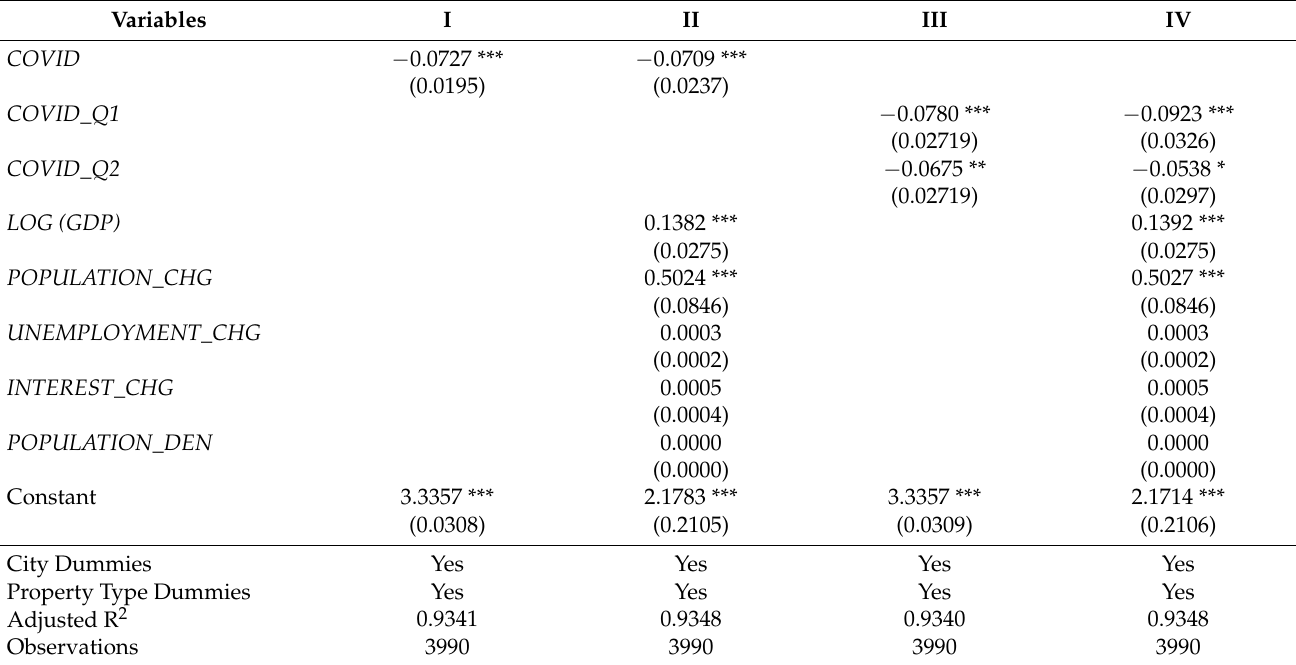
Table 3. The Impact of the COVID-19 Pandemic on Rent Dynamics. This table presents the OLS regression estimation results of testing the impact of the COVID-19 pandemic on commercial real estate rent. The dependent variable is LOG (RENT) , the natural logarithm of rent for the specific city and property type. The independent variables of interest are COVID , COVID_Q1 and COVID_Q2 . All variables are described in Appendix A. The standard errors are reported in parentheses. ***, **, and * denote significance of the t-statistics at the <1%, 5% and 10% levels,